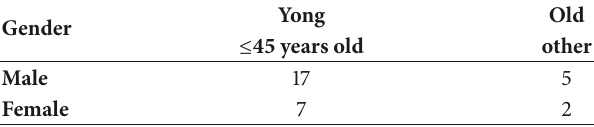
Table 1: Distribution of drivers’ demographic